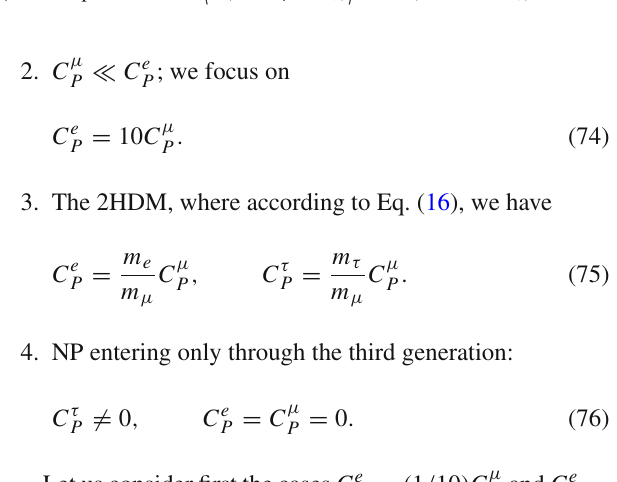
tions B ( B − → μ − ¯ ν μ ) or